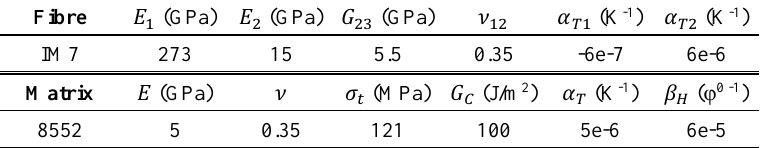
Table 1. Summary of key constituent properties obtained from